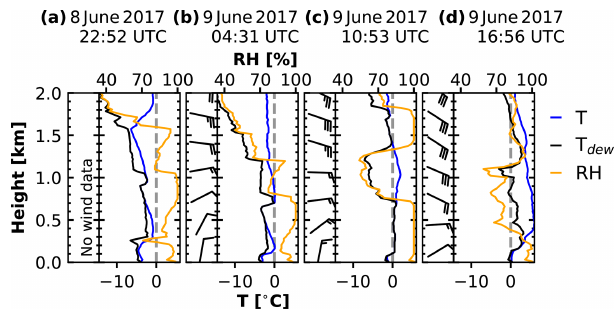
Figure 9. Thermodynamic profiles from radiosondes launched aboard Polarstern on (a) 8 June 2017 22:52UTC, (b) 9 June 2017 04:31UTC, (c) 9 June 2017 10:53UTC, and (d) 9 June 2017 16:56UTC up to 2km height. Each sounding is divided into two parts: left side the wind barbs and right side the temperature (blue), dew point temperature (black), and relative humidity (orange) pro- files.